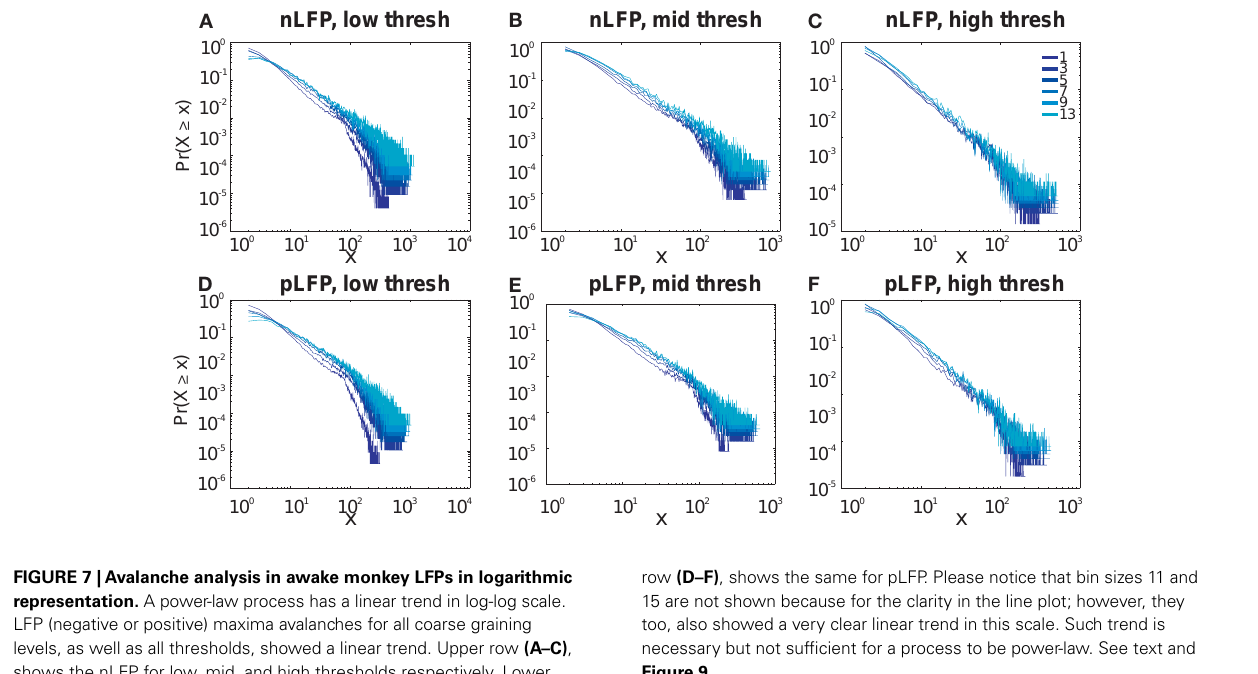
FIGURE 7 |Avalanche analysis in awake monkey LFPs in logarithmic representation. A power-law process has a linear trend in log-log scale. LFP (negative or positive) maxima avalanches for all coarse graining levels, as well as all thresholds, showed a linear trend. Upper row (A–C) , shows the nLFP for low, mid, and high thresholds respectively. Lower